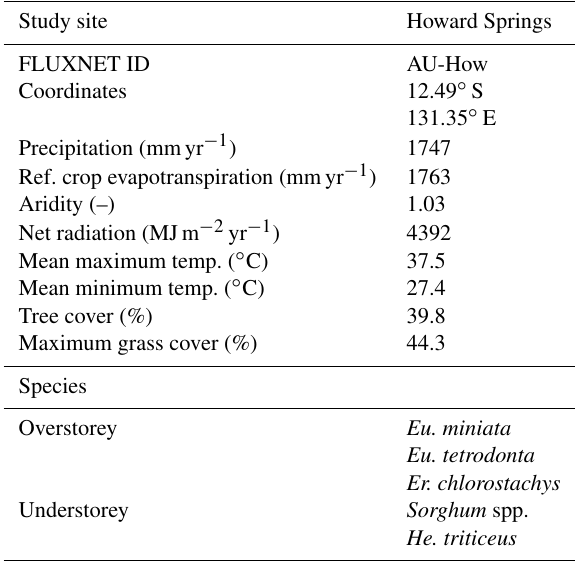
Figure 1. Location of the Howard Springs site, together with the other flux tower sites that are part of the North Australian Tropical Transect in the Northern Territory of Australia, with the mean an- nual precipitation shown on the blue colour scale (SILO Data Drill, Jeffrey et al., 2001, calculated for 1980–2017). Table 1. Characteristics of the Howard Springs site. Vegetation data from Hutley et al. (2011) and Whitley et al. (2016), with Eucalyptus (Eu.), Erythrophleum (Er.), and Hetropogan (He.). Meteorological data are taken from the SILO Data Drill (Jeffrey et al., 2001) for the model periods of 1 January 1980 until 31 December 2017, with the reference crop evapotranspiration calculated according to the FAO Penman–Monteith formula (Allen et al., 1998). The ratio of the net radiation R n to the latent heat of vaporization λ multiplied by the precipitation P is defined here as the aridity R n /λP . Tree cover is determined as the minimum value of the mean monthly projective cover based on fPAR observations (Donohue et al., 2013). The max- imum grass cover was found by subtracting the tree cover from the remotely sensed projective